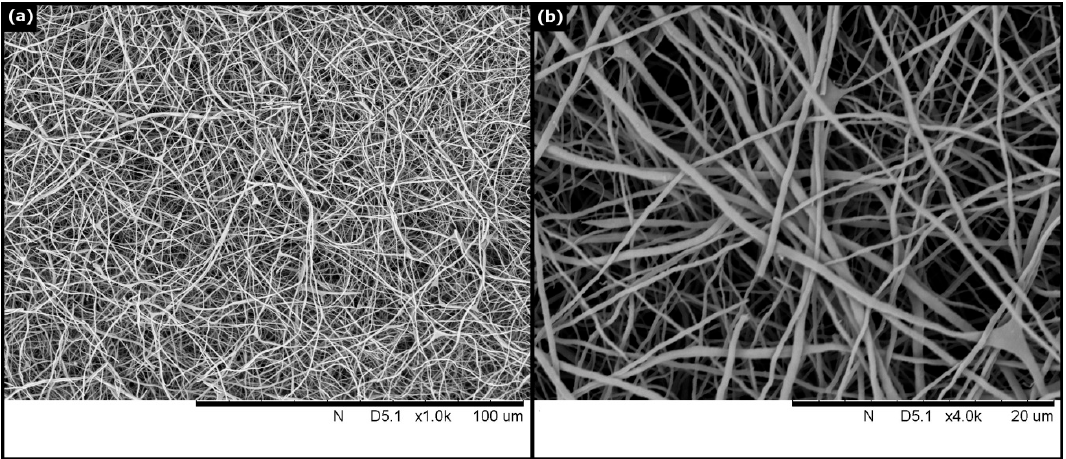
Figure 1. SEM micrograph of the HANFs. ( a ) 1000×. ( b ) 4000×.